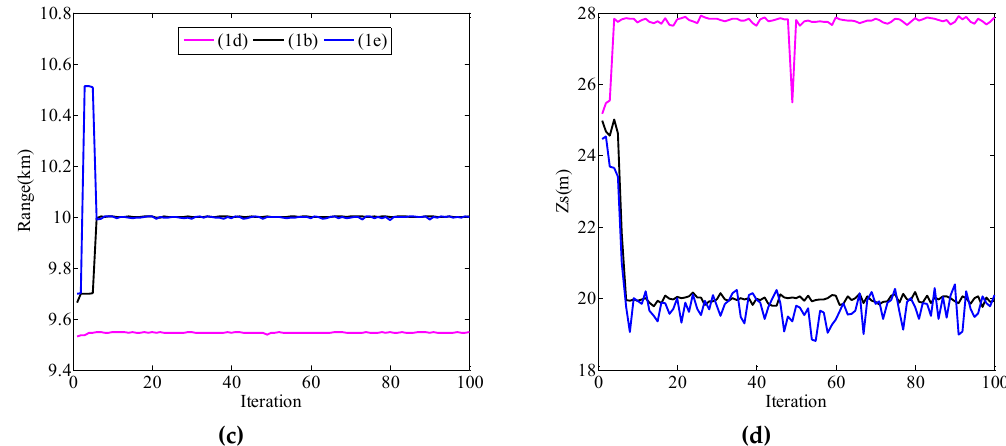
Q when k when the initial Q when k k